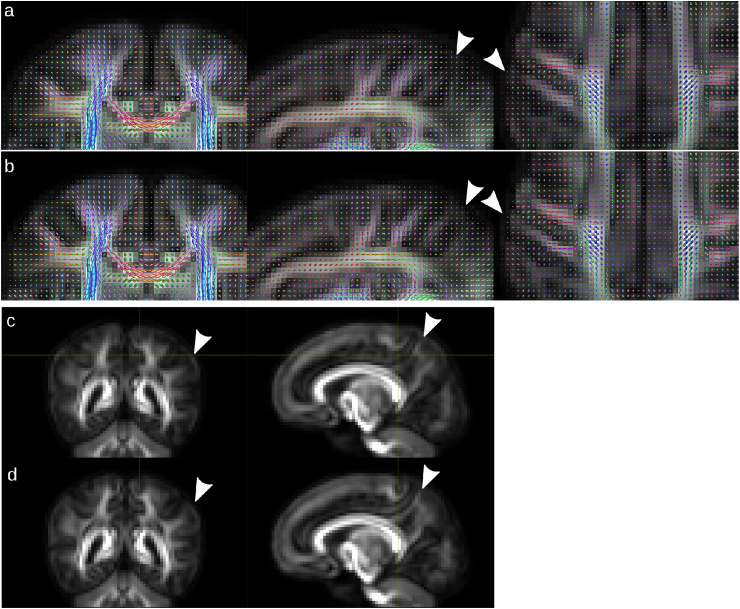
Comparison of templates of registration driven by WM only (a,c) with registration driven by the CSF and WM components simultaneously (b,d). The background image is the power in the second spherical harmonic degree. Arrowheads point to positions where the joint registration clearly yields sharper features. The image is an average of 27 subjects scanned at term equivalent age.